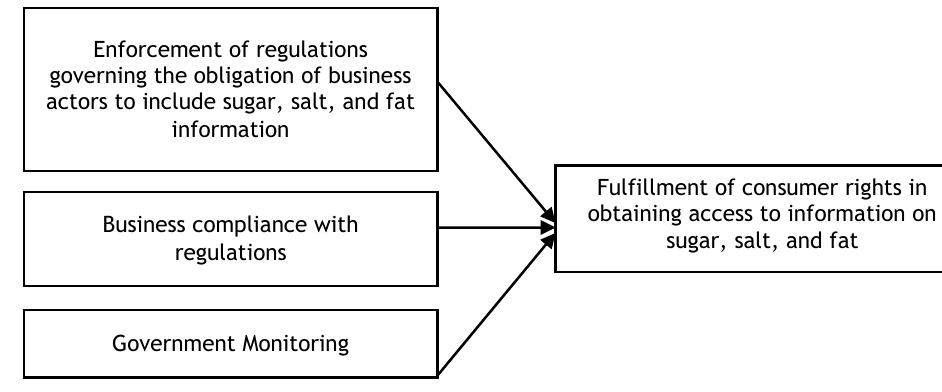
Figure 1. Conceptual framework of the